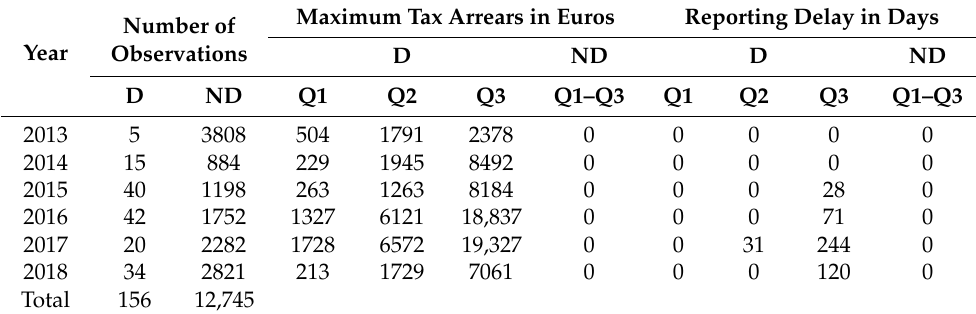
Table 1. Overview of the